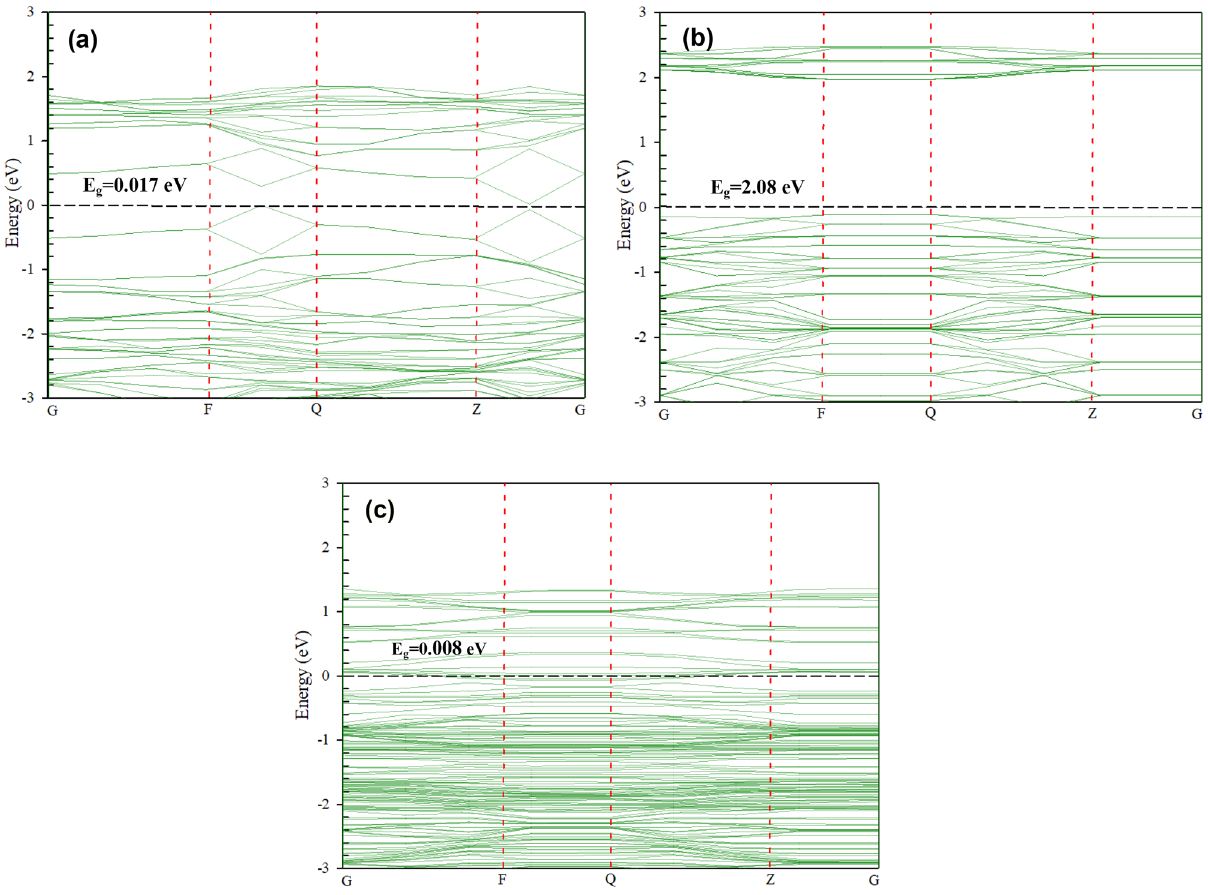
Figure 3. Band structures of: ( a ) CNT; ( b ) MoS 2 ; and ( c ) MoS 2 /CNT.